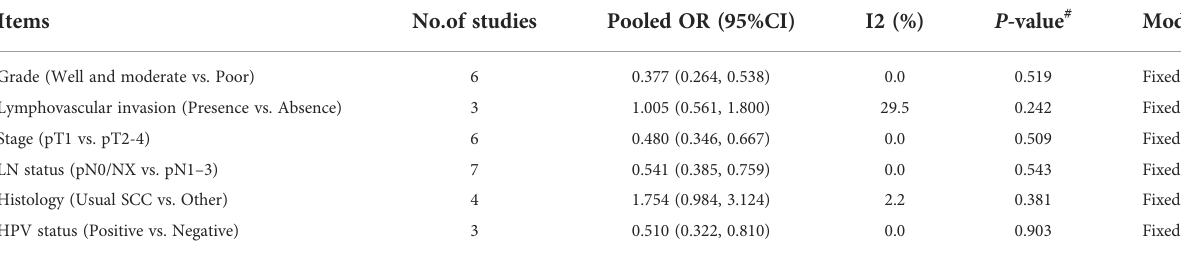
TABLE 3 Association between PD-L1 expression and clinicopathological features of penile carcinoma.